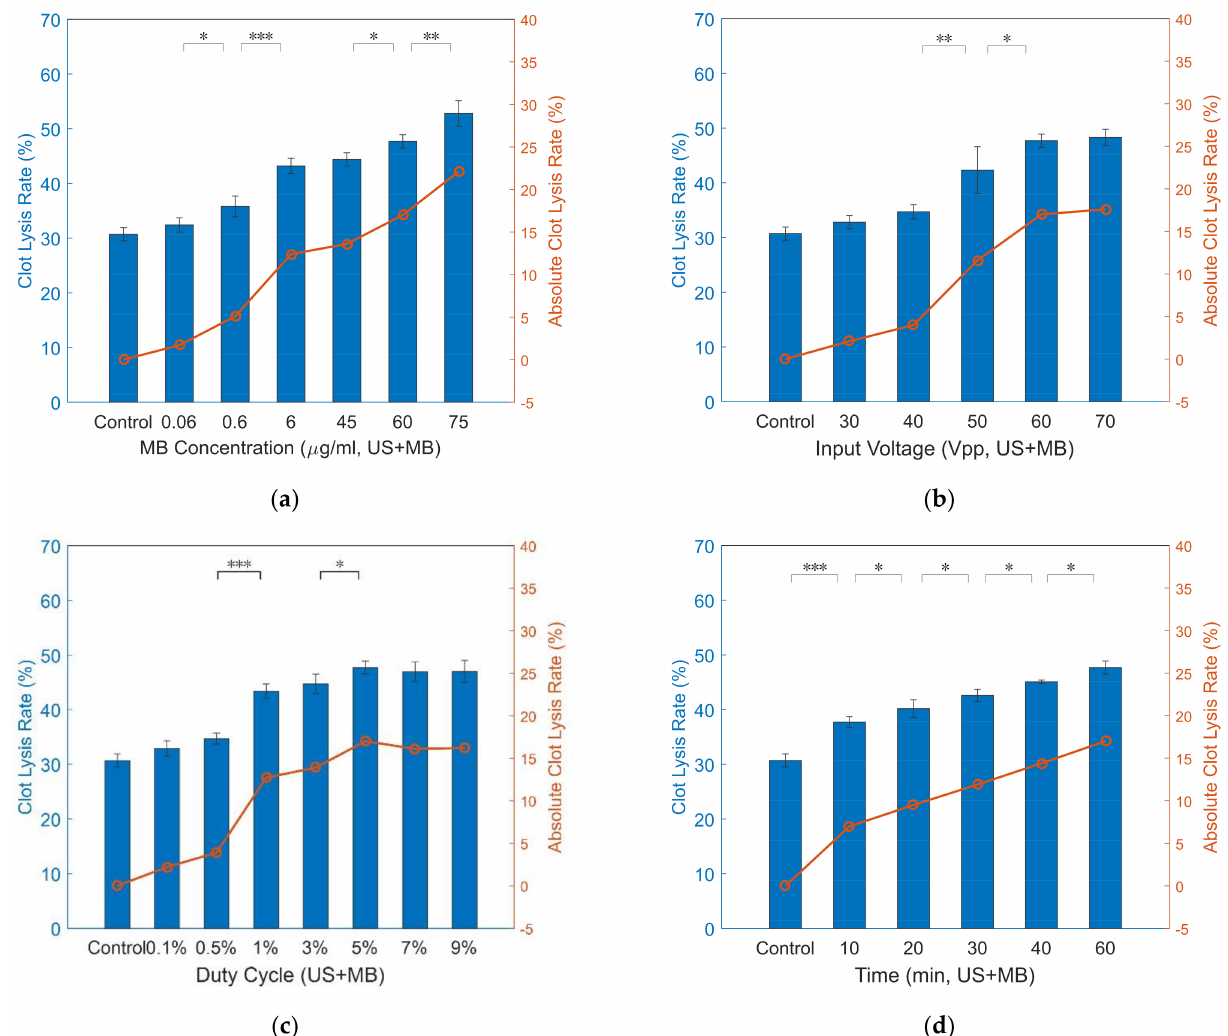
Figure 12. In vitro US + MB experiment results. ( a ) Clot lysis vs. MB concentration ( n = 3, US settings of 1.1 MHz, 60 V pp input voltage, 500 PRF, 5% duty cycle, 60 min treatment). ( b ) Clot lysis vs. input voltage ( n = 3, US settings of 1.1 MHz, 500 PRF, 5% duty cycle, 60 µ g/mL, MB injected at 1 mL/h, 60 min treatment). ( c ) Clot lysis vs. duty cycle ( n = 3, US settings of 1.1 MHz, 60 V pp input voltage, 500 PRF, 60 µ g/mL, MB injected at 1 mL/h, 60 min treatment). ( d ) Clot lysis vs. time ( n = 3, US settings of 1.1 MHz, 60 V pp input voltage, 500 Hz PRF, 60 µ g/mL, MB injected at 1 mL/h) (*** p < 0.001, ** p < 0.01, * p <